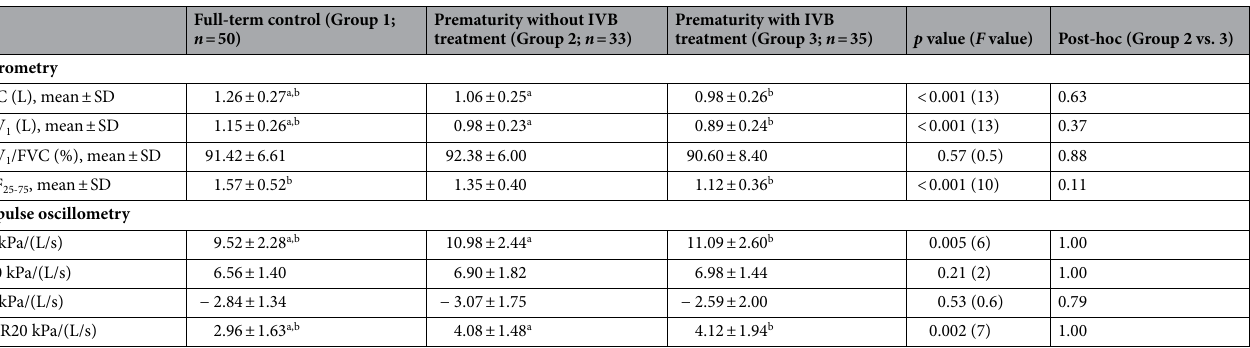
Table 2. Pulmonary function outcomes. FEF 25–75 forced expiratory flow between 25 and 75% of FVC; FEV 1 forced expiratory volume in 1 second; FEV 1 /FVC ratio of FEV 1 to FVC; FVC forced vital capacity; IVB intravitreal injection of Bevacizumab; R5 respiratory resistance at 5 Hz; R20 respiratory resistance at 20 Hz; R5–R20 difference between respiratory resistance at 5 Hz and 20 Hz; SD standard deviation; X5 respiratory reactance at 5 Hz. P values calculated by analysis of variance and post hoc tests performed by the Bonferroni test. a Significant difference between groups 1 and 2. b Significant difference between groups 1 and 3.